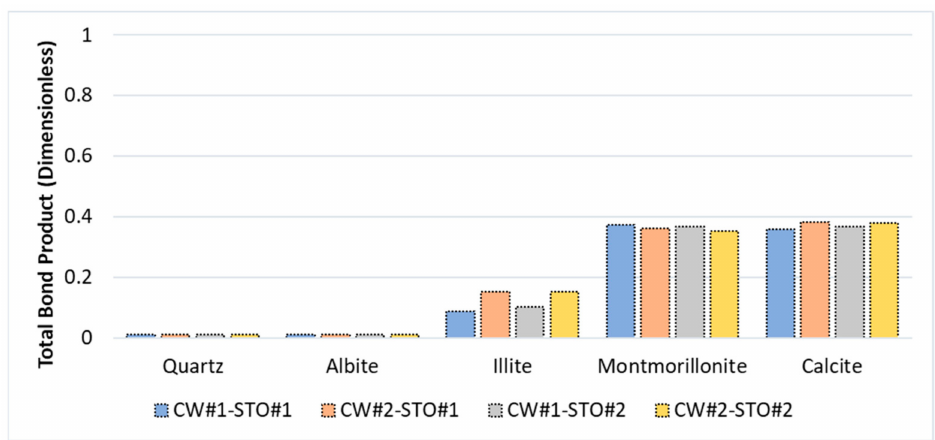
Figure 3. Total bond product (oil adhesion tendency) of minerals during CWI.